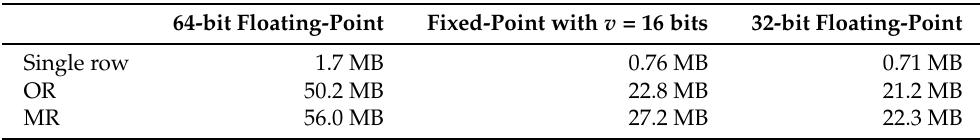
Table 4. CGNE’s memory footprint with fixed-point or 32-bit floating-point representation. “Single row” denotes the memory footprint for only one row in the OR model, and v denotes the number of bits for the fractional part of the fixed-point encoding.